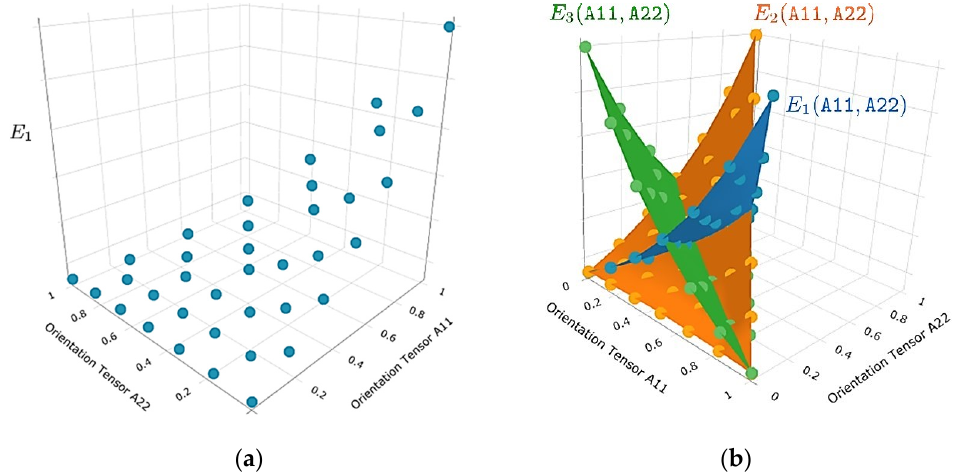
Figure 8. Visualization of the properties of generated variable material response with respect to the axes of principal orientations: ( a ) interpolation grid for E1 and ( b ) interpolation grids and interpolation surfaces for E1, E2 and E3 as functions of principal orientations A11 and A22. The user is given the possibility to generate analogous plots for the other 6 homogenized elastic parameters of the orthotropic behavior in the coordinate system defined by the principal axes of 2nd order orientation tensors.